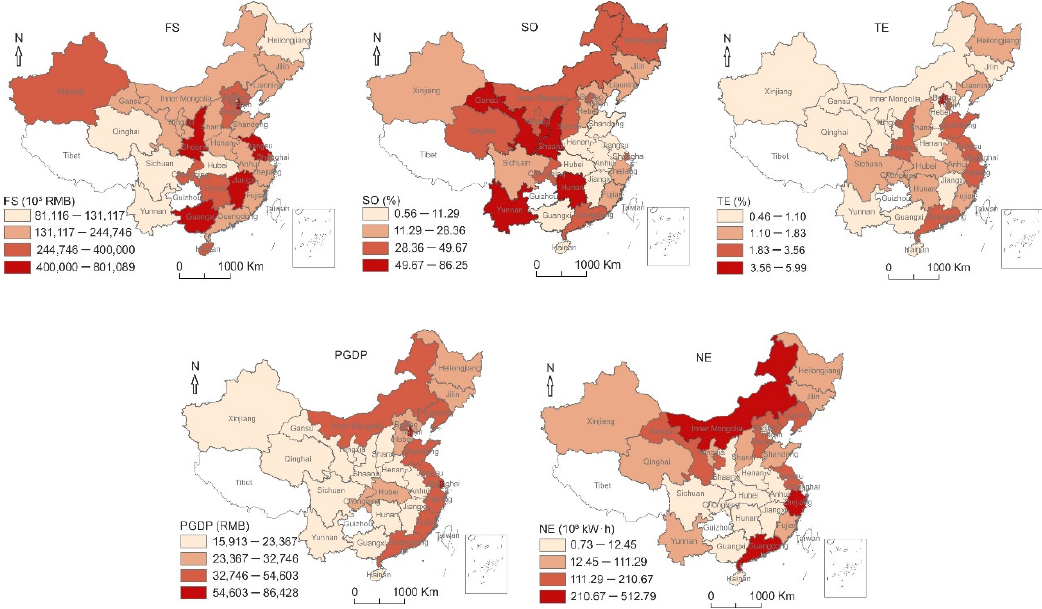
Figure 3. The spatial distribution of the driving factors across China in